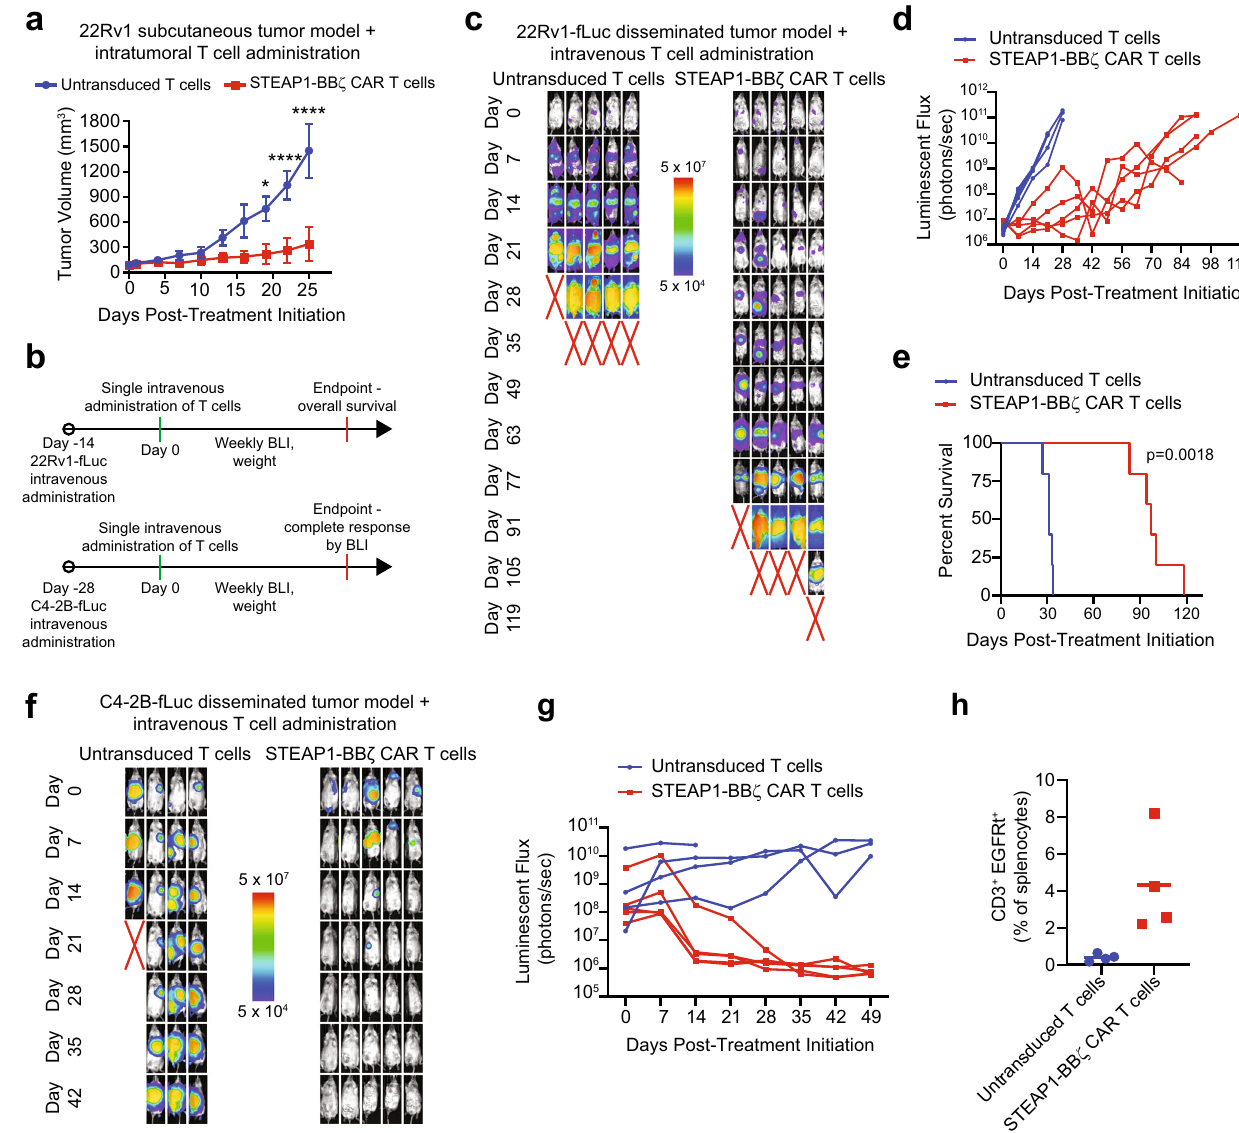
Fig. 3 | In vivoantitumoractivity ofSTEAP1-BB ζ CAR T celltherapy in prostate cancermodelswithnativeSTEAP1expression.a Volumesof22Rv1subcutaneous tumorsinNSGmice( n =4foruntransduced Tcellsgroup and n =5forSTEAP1-BB ζ CAR T cells group) over time after a single intratumoral injection of 5×10 6 untransduced T cells or STEAP1-BB ζ CAR T cells at normal CD4/CD8 ratios. p <0.0001 at day 20 and 25. Bars represent mean with SEM. b Schematic of tumor challenge experiments for 22Rv1 (top) and C4-2B (bottom) disseminated models. fLuc fi re fl y luciferase, BLI bioluminescence imaging. c Serial live bioluminescence imaging(BLI)ofNSGmiceengraftedwith22Rv1-fLucmetastasesandtreatedwitha single intravenous injection of 5×10 6 untransduced T cells or STEAP1-BB ζ CAR TcellsatnormalCD4/CD8ratiosonday0.RedXdenotesdeceasedmice.Radiance scaleisshown. d Plotshowingthequanti fi cationoftotal fl uxovertimefromliveBLI of each mouse in ( c ). e Kaplan – Meier survival curves of mice in ( c ) with statistical